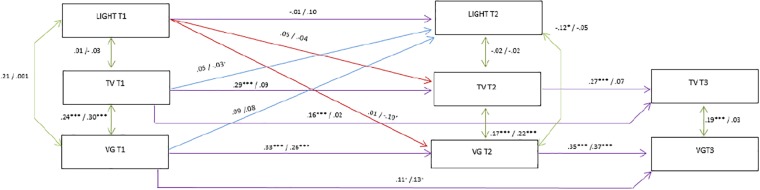
Associations between light activity, TV and VG (Males n = 436, Females n = 374).Results from structural equation modelling. Estimates (standardized) are displayed as males/females. *** p<0.001, ** p<0.01, * p<0.05(baseline confounders were omitted) The Adolescent Nutritional Assessment Longitudinal Study, 2010–2012, Brazil.